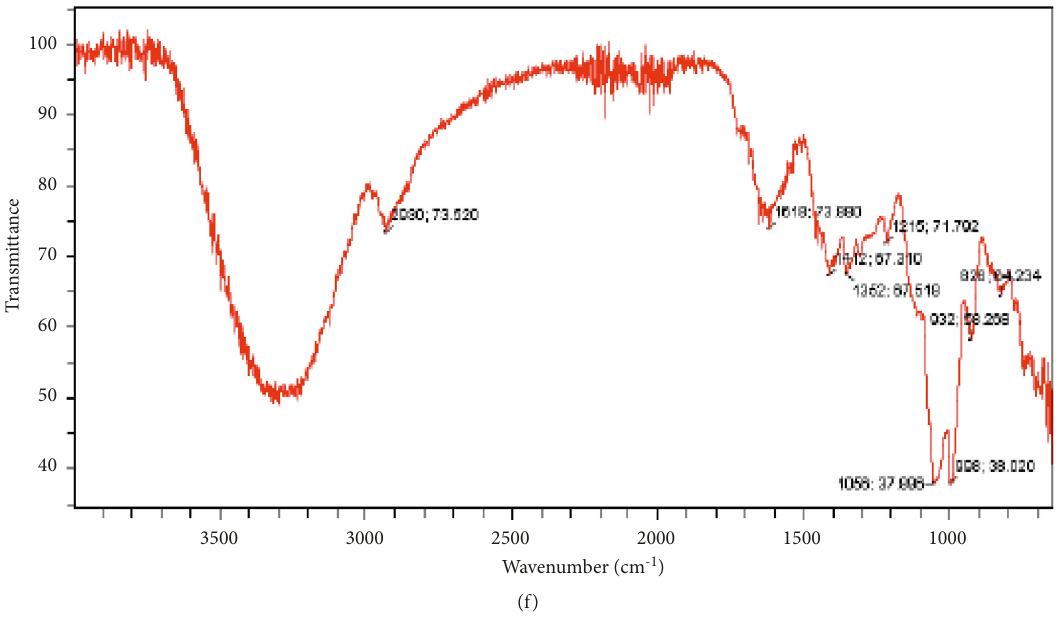
Figure 1: FTIR spectra of (a) LP, (b) MP, (c) WMP, (d) MnP, (e) A-WMP, and (f) BWMP.